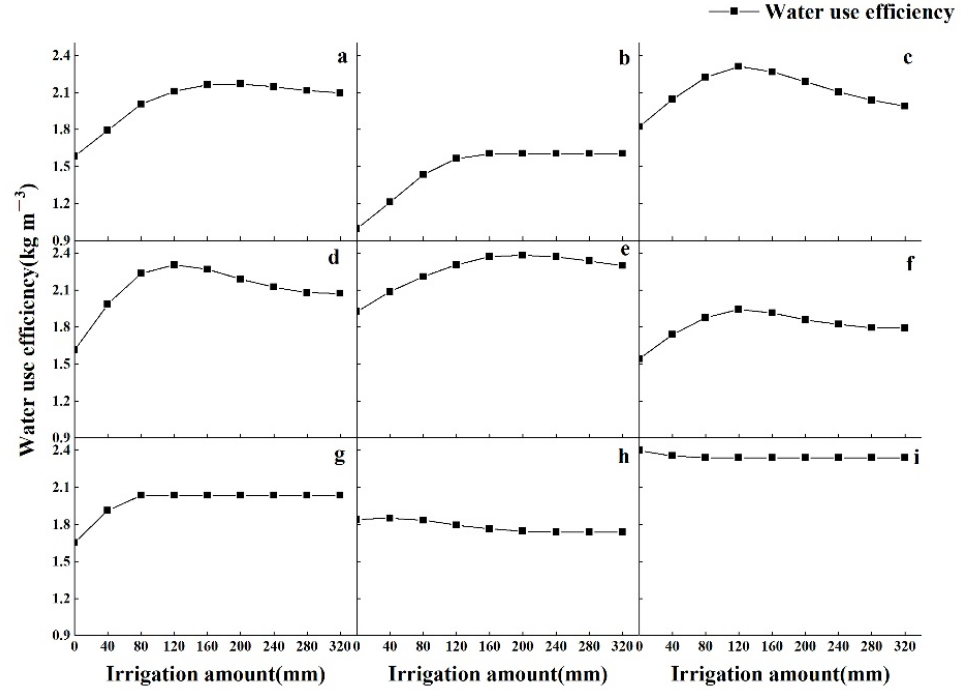
Figure 3. Changes in water use efficiency of winter wheat with irrigation levels in the North China Plain. ( a ) Tangshan, ( b ) Huanghua, ( c ) Luancheng, ( d ) Huimin, ( e ) Nangong, ( f ) Ganyu, ( g ) Shangqiu, ( h ) Zhumadian, ( i ) Shouxian.